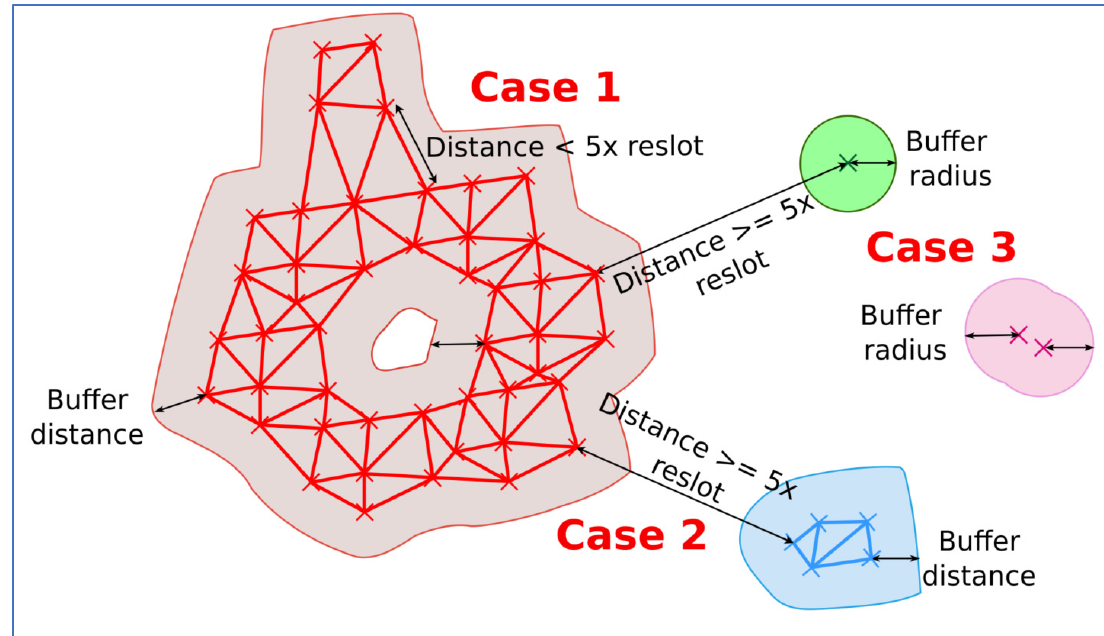
Figure 4. Shom MES definition.